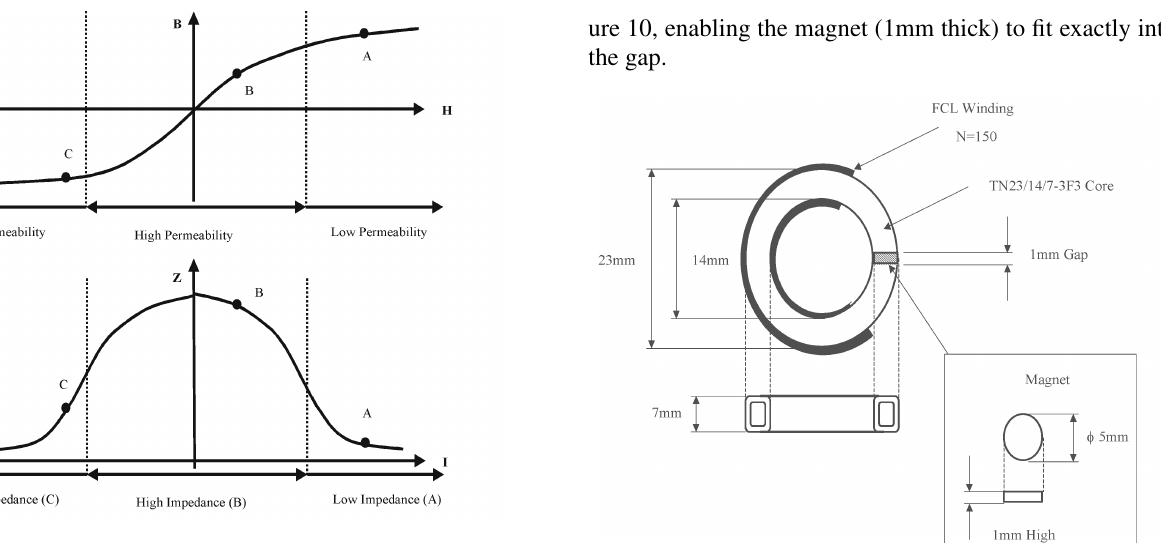
Figure 9: FCL Averaged BH & Impedance Curves